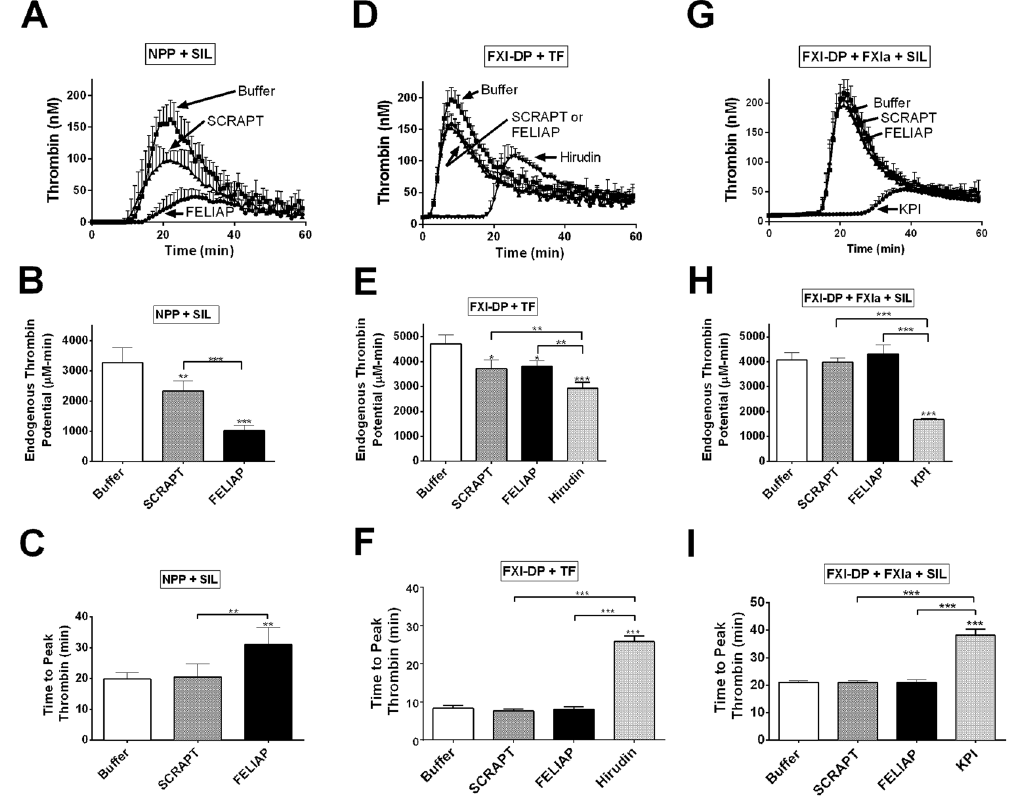
Figure 5. Inhibition of thrombin generation by FELIAP. Thrombin generation assays (TGA) were conducted in 3 different ways: in recalcified human normal pooled plasma (NPP) using micronized silica (SIL) for contact activation as the initiator (NPP + SIL, panels A-C); in FXI-depleted plasma (FXI-DP) using tissue factor for extrinsic pathway activation as the initiator (FXI-DP + TF, panels D-F); and following 0.25 nM FXIa pre-incubation with Buffer, 1 µ M SCRAPT, or 1 µ M FELIAP, in FXI-DP activated with micronized silica (FXI-DP + FXIa + SIL). Thrombin concentration was determined fluorescently every minute for 60 minutes in each case. ( A ) TGA progress curves (mean ± SD (n = 6) with addition of agents (Buffer, 30 μ M FELIAP, or 30 μ M SCRAPT) as indicated by labels and arrows. Upwards error bars are shown. ( D ) As in A, but n = 5, and with additional assays including 0.2 µ M recombinant hirudin variant 3 (Hirudin). ( G ) FELIAP, SCRAPT or KPI was pre-incubated with FXIa (1 µ M: 0.25 mM inhibitor: enzyme ratio) and then diluted into FXI-DP activated with micronized silica for TGA. Progress curves (mean ± SD (n = 5)) are shown. Each set of TGA progress curves ( A , D , G ) are quantified with respect to endogenous thrombin potential (the area under the thrombogram curve) ( B , E , H ) and time to peak thrombin ( C , F , I ) in panel columns. Bar graphs are derived from analysis of individual thrombogram curves corresponding to plasma supplementation with Buffer (white), SCRAPT (grey), FELIAP (black), or, in some reactions KPI or Hirudin (light grey). Symbols (above the error bars) indicate statistically significant differences from Buffer reactions, while symbols above the horizontal bar indicate statistically significant differences between SCRAPT- and FELIAP-supplemented and other reactions: p < 0.001, * ; * p < 0.001, ***